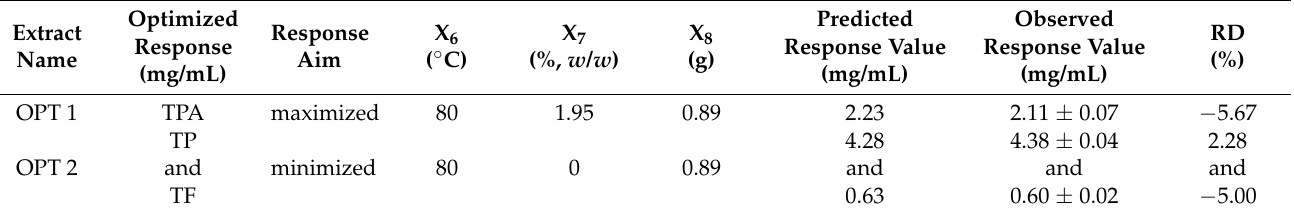
Table 6. Predicted and observed response values for the extracts prepared in optimal